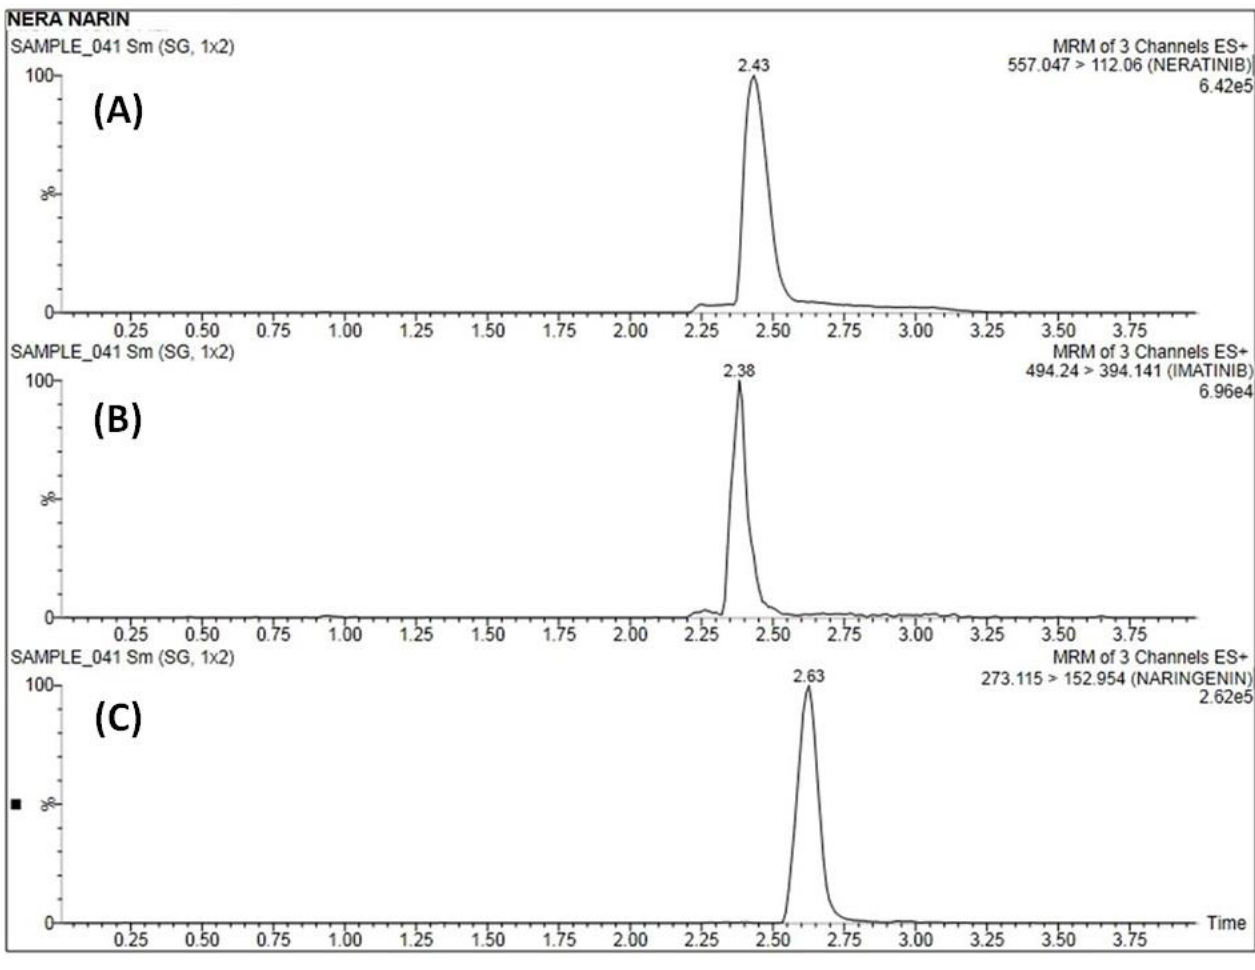
Figure 4. Representative MRM chromatogram of blank plasma samples of ( A ) NER, ( B ) IS, and ( C ) NRN at